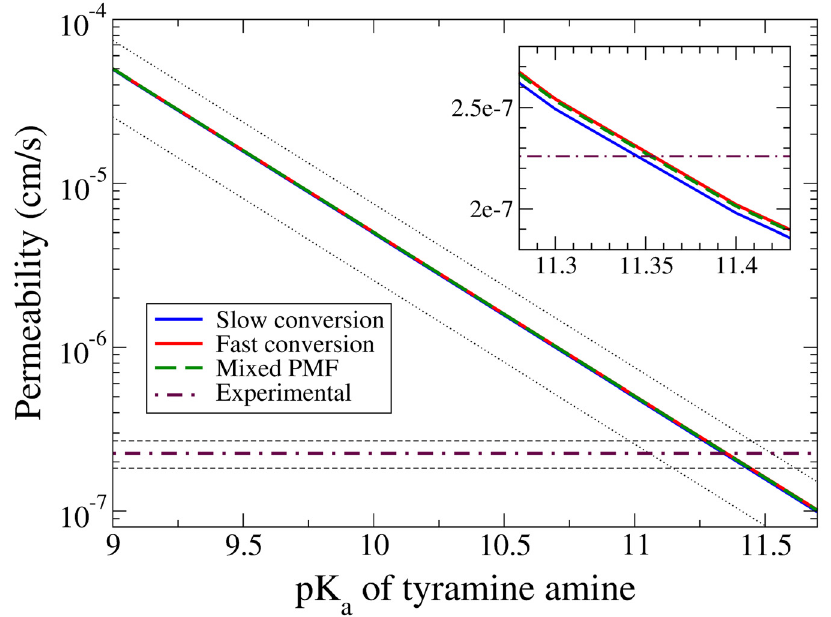
Fig 8. The permeability of tyramine calculated over the reported range of pK a values for the amine group. The single standard error uncertainty for the simulated values (Slow conversion, Fast conversion, Mixed PMF) are plotted as black dotted lines, while the uncertainty for the experimental result is shown as black dashed lines. The inset is an expansion of the region where the plots converge.